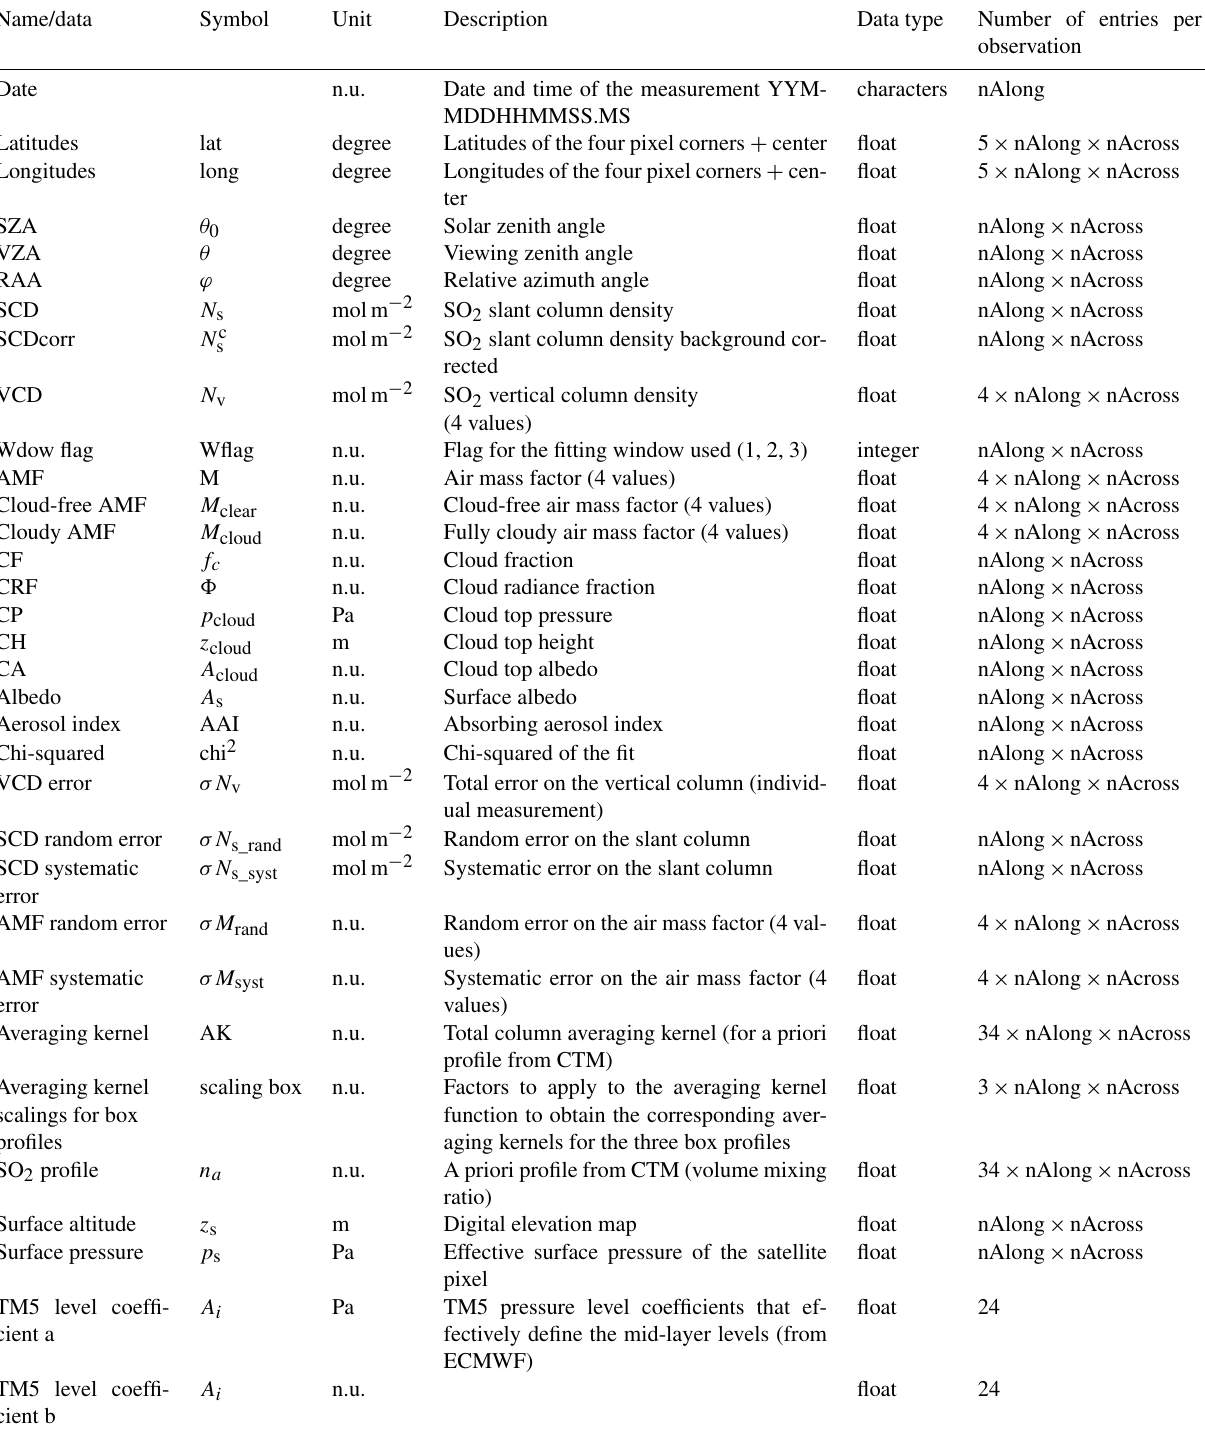
Table A1. List of output fields in the TROPOMI SO 2 products. nAlong × nAcross corresponds to the number of pixels in an orbit along track and across track, respectively; n.u.: no